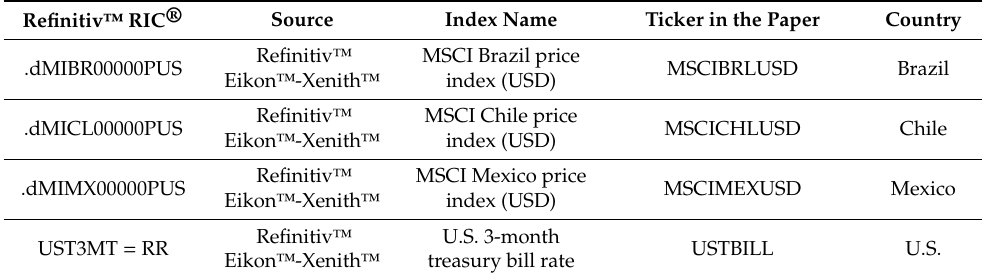
Table 1. The Latin American stock indexes that will be used in simulating the investment